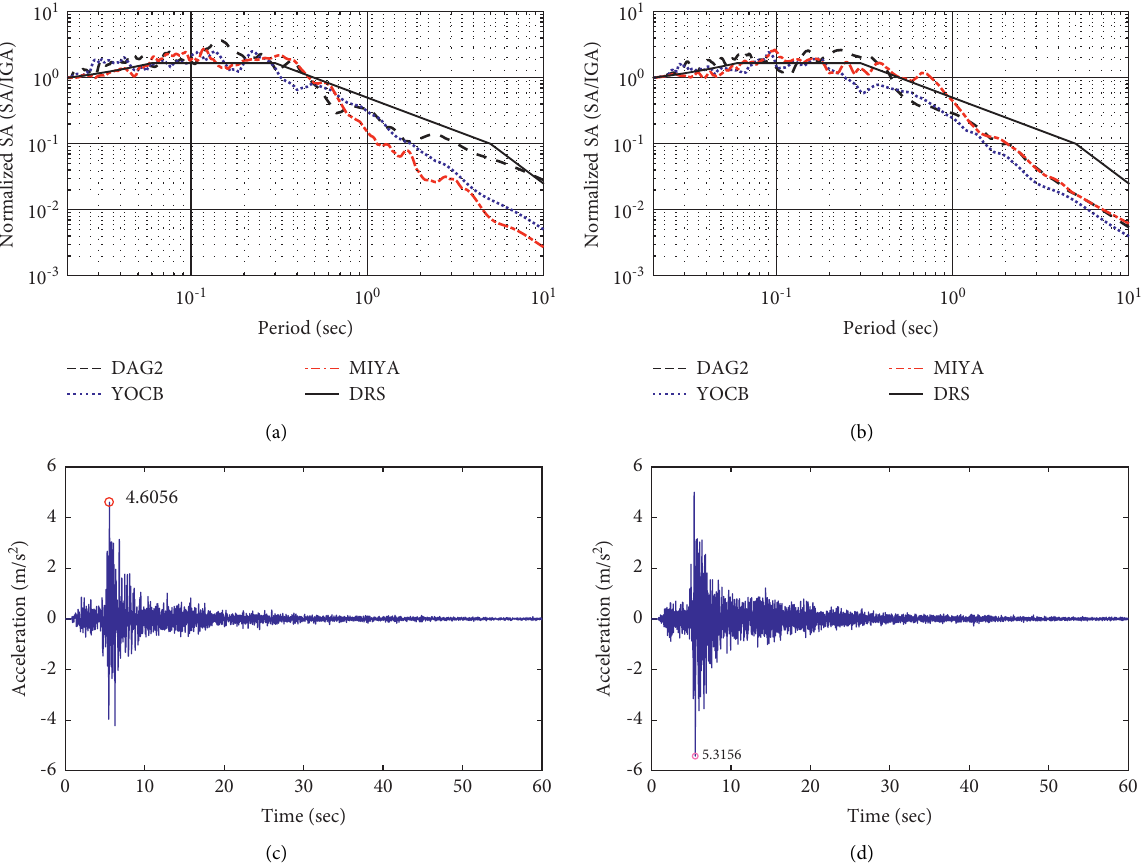
Figure 4: Acceleration response spectra and time history of Gyeongju earthquake monitored at three stations. (a) Comparison of normalized SA in EW direction. (b) Comparison of normalized SA in NS direction. (c) Acceleration time history in EW direction at DAG2. (d) Acceleration time history in NS direction at DAG2. Table 4: Comparison of fundamental transverse natural frequencies between the full and lumped mass models (unit: Hz). EW direction NS direction Mode Full Lumped mass Full Lumped mass 1